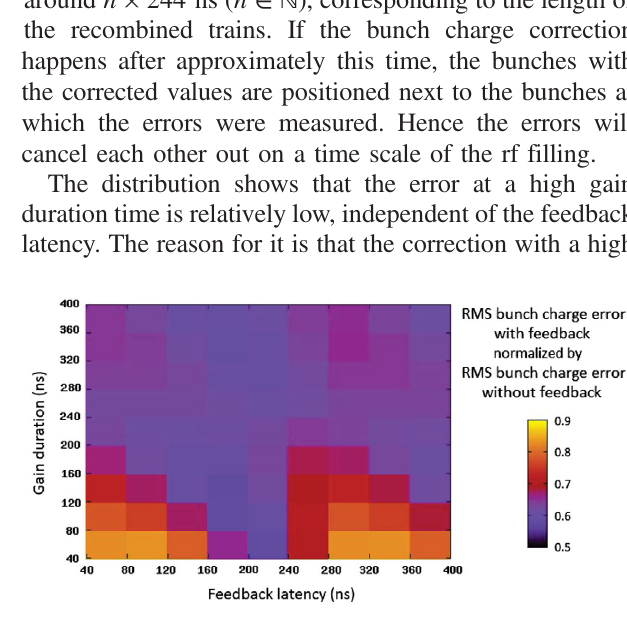
FIG. 16. Phase error caused by 0.05% drive beam rf amplitude jitter vs frequency of the rf amplitude jitter, calculated with realistic rf filling and beam loading functions. The maximal phase error value of 170 μ m correspond to 2.5° at 12 GHz.